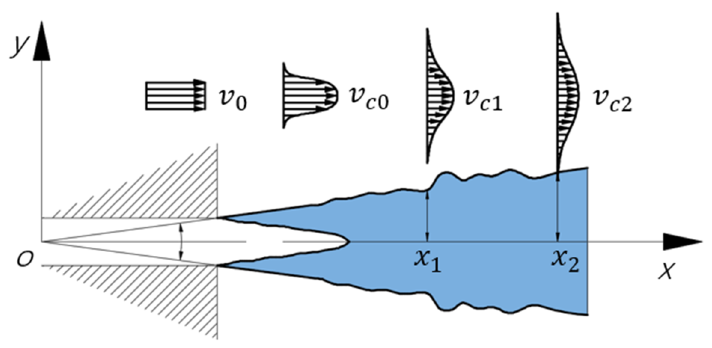
Figure 5. Thestructure of the unsubmerged water jet.